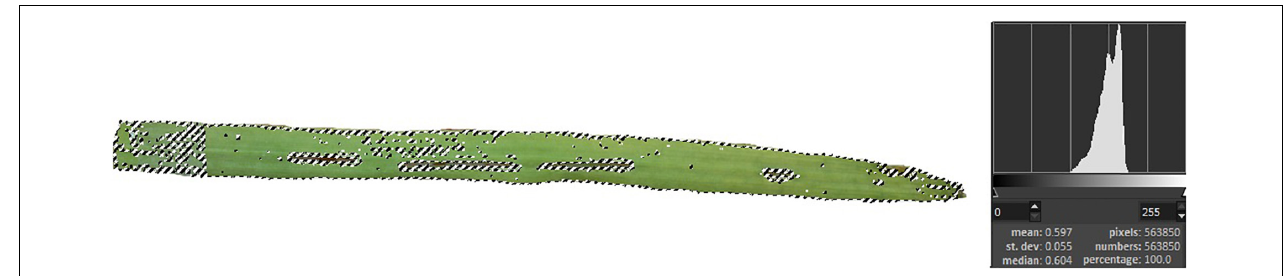
FIGURE 1 | Leaf surface destruction caused by O. melanopus . Five leaves were scanned and the pixels of damaged leaves were determined in the percentage of reduction of the photosynthesizing surface.